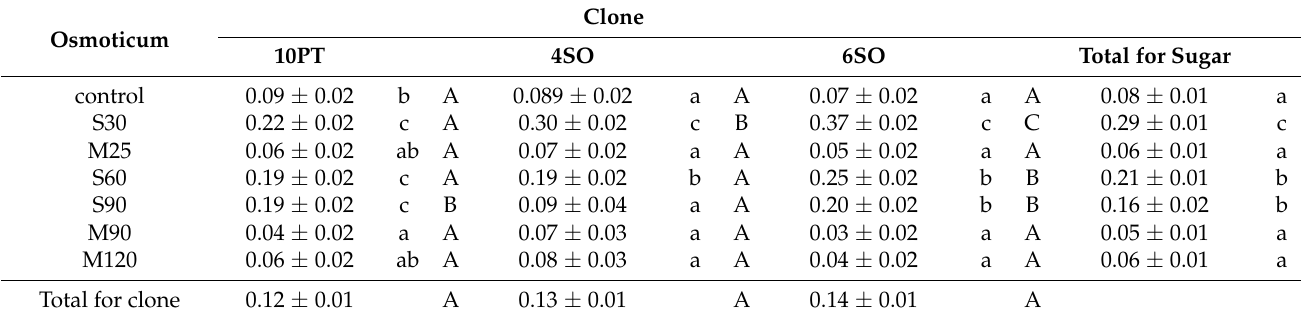
Table 10. Mean ± SE fresh weight FW (g) of R. pseudoacacia clones (10PT, 4SO, 6SO) for different osmotic treatments. Different treatments are denoted as: “control”—medium without osmoticum, “S30”—medium with 30 gL − 1 of sucrose, “S60”—medium with 60 gL − 1 of sucrose, “S90”—medium with 90 gL − 1 of sucrose, “M25”—medium with 25 gL − 1 of mannitol, “M90” medium with 90 gL − 1 of mannitol, “M120” medium with 120 gL − 1 of mannitol. Effect of Clone × Osmoticum. Clone 4SO 6SO